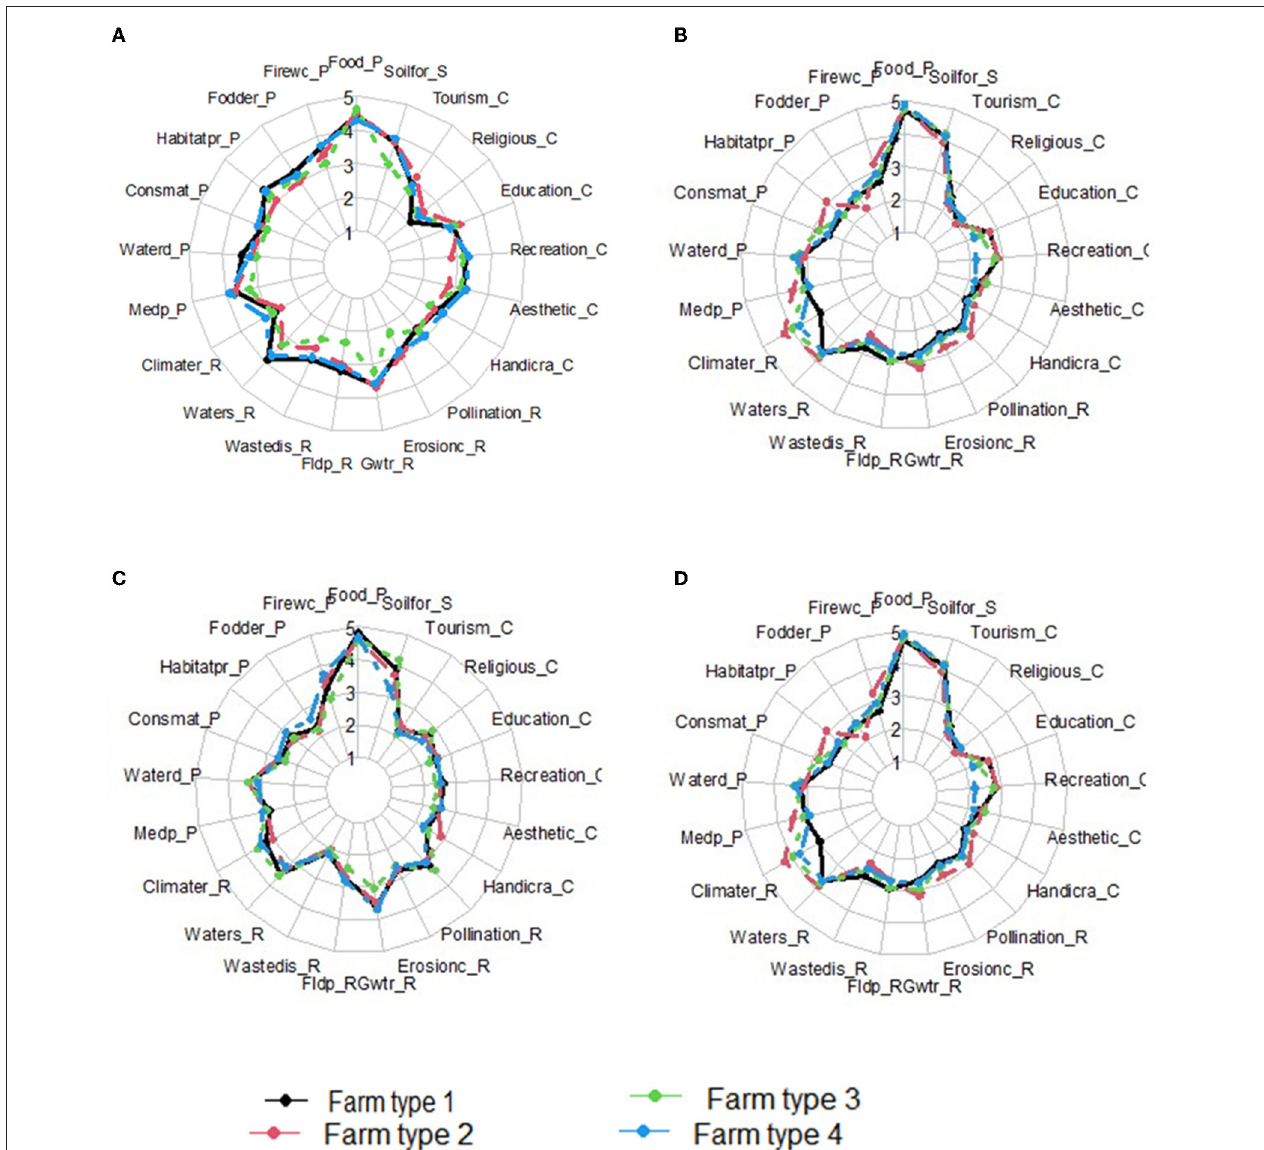
FIGURE 5 | Ecosystem services at farm level in different in (A) Bouaké [top left], (B) Ahafo Ano North [bottom left], (C) Gagnoa [top right], and (D) Ahafo Ano South [bottom right]. P, R, S and C indicate provisioning, regulating, supporting, and cultural ecosystems services, respectively. Firew_C: Firewood and Charcoal, Habitat_Pr: habitat provision, Consmat: Construction material, Medp: Medicinal plants, Waterd: Water for domestic use, Climater: Climate regulation, Waters: Water storage, Wastedis: Waste disposal, Fldp: Flood protection, Gwtr: Groundwater recharge, Erosionc: Erosion control, Pollination: Pollination insects, Soilfor: Soil formation, Handicra: Handicrafts, Aesthetic: Aesthetic values, Recreation: Recreational values, Religious: Religious values.